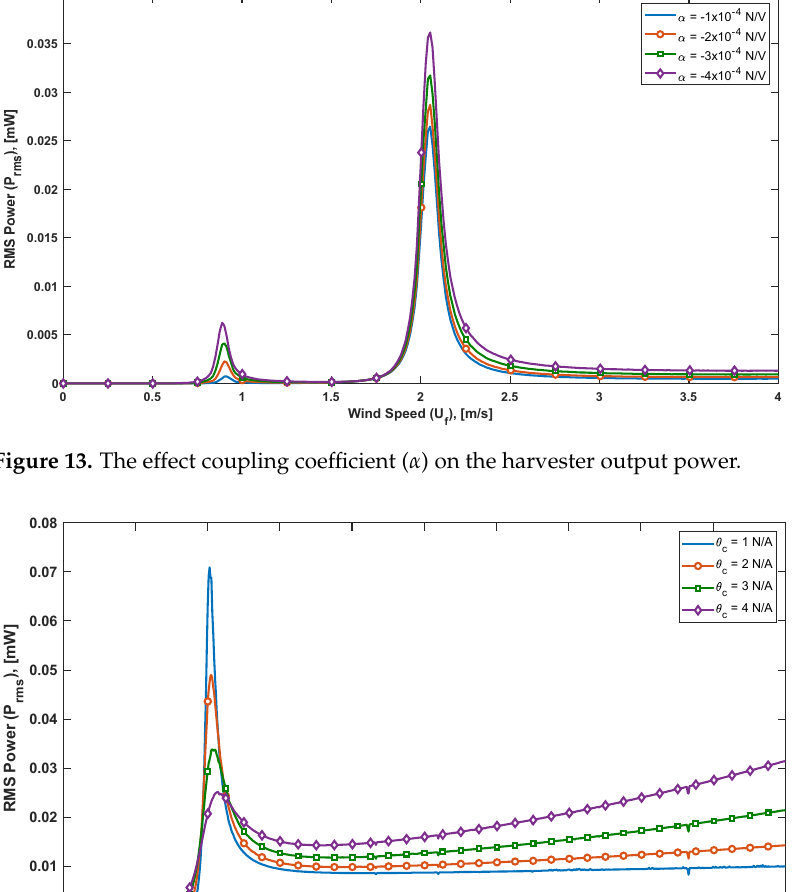
c ) on the harvester output